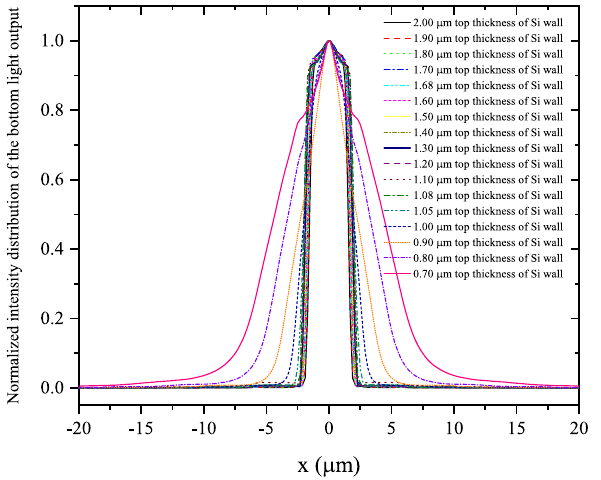
Figure 4. Normalized intensity distributions of BLOs of the structured CsI(Tl) screens with different t Si .